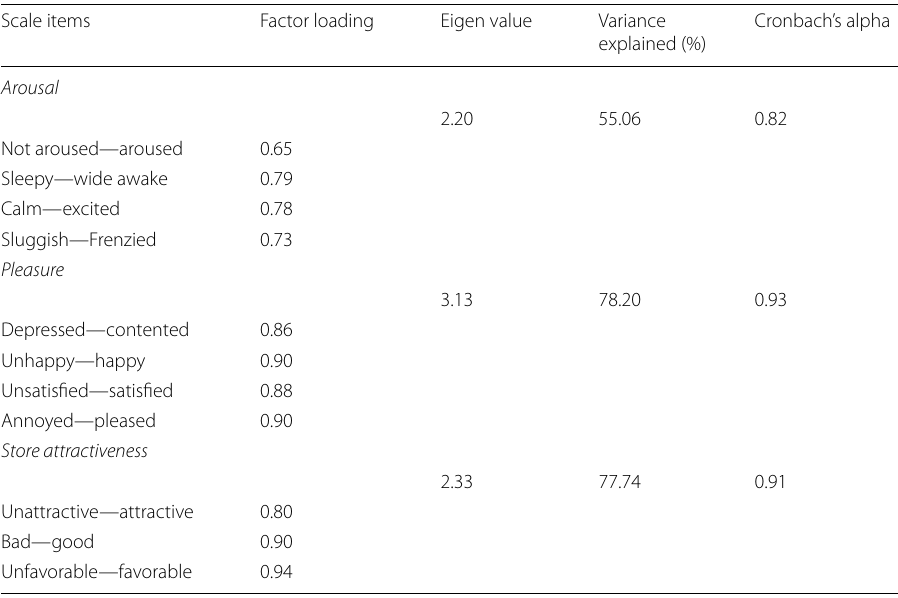
Table 3 Exploratory factor analysis and